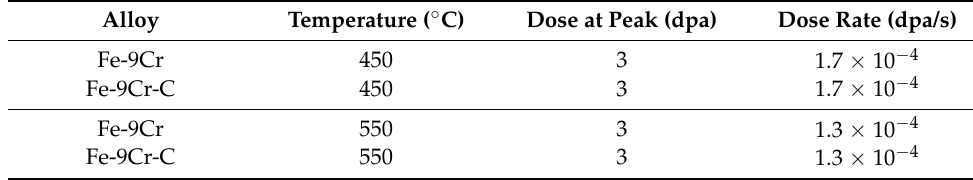
Table 2. The irradiation conditions of